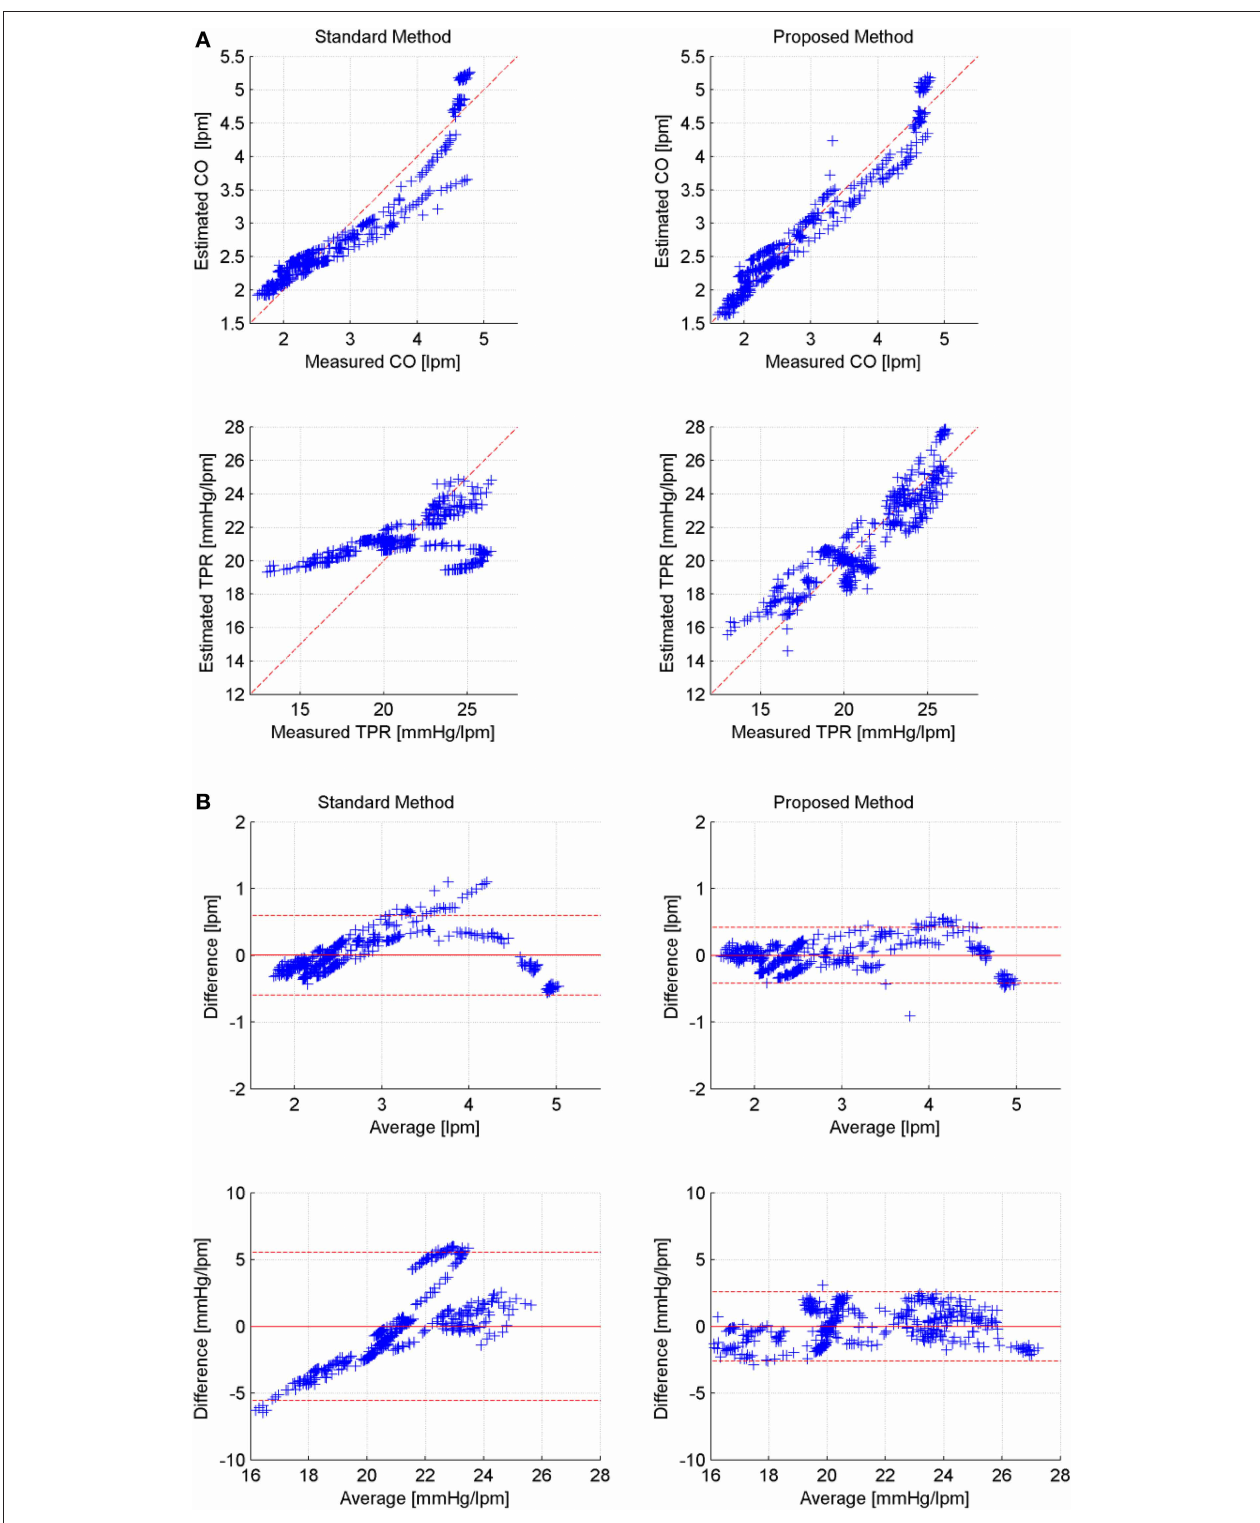
FIGURE 2 | Representative correlation and limits of agreement: measured versus estimated CO and TPR (Subject #1). (A) Correlation between measured versus estimated CO and